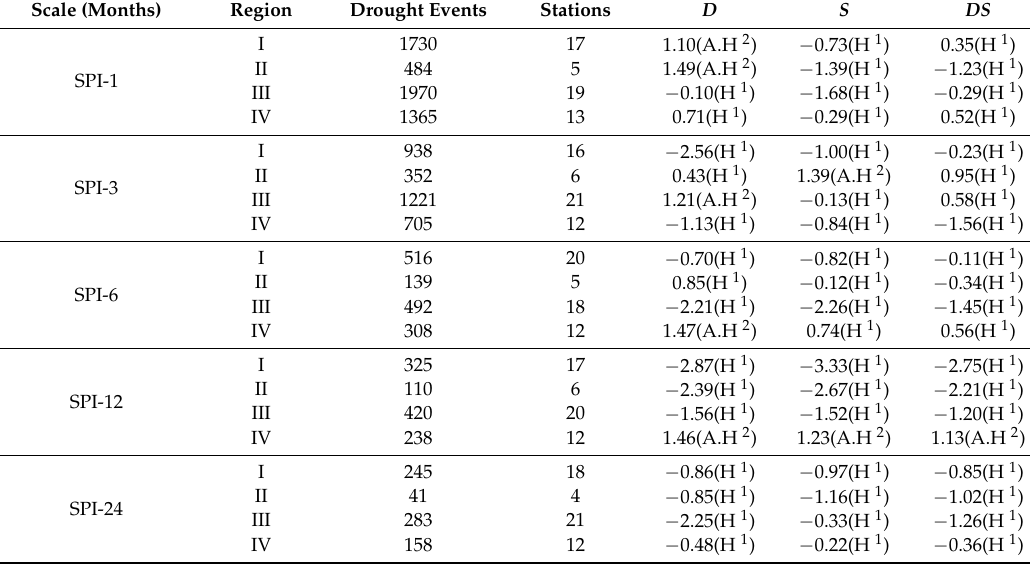
Table 5. Heterogeneity measure for the final adjusted homogeneous regions on different time scales. Scale (Months) Region Drought